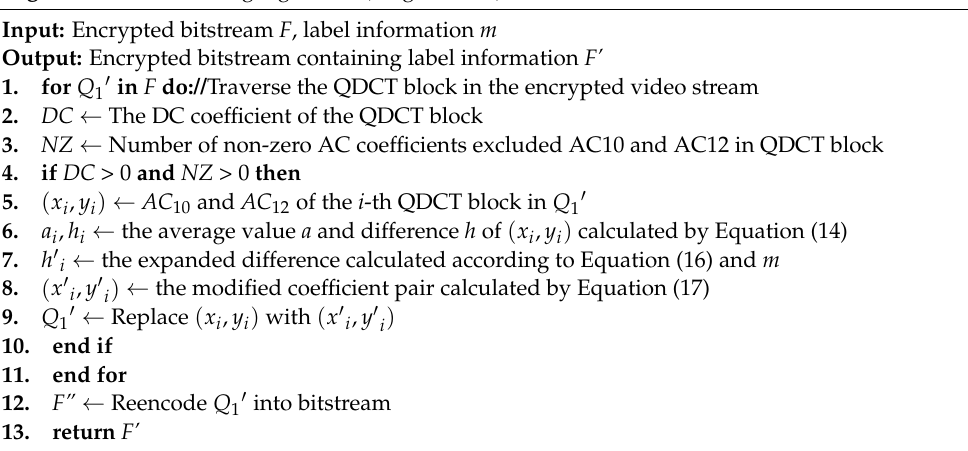
Algorithm 1 . Embedding algorithm (Single